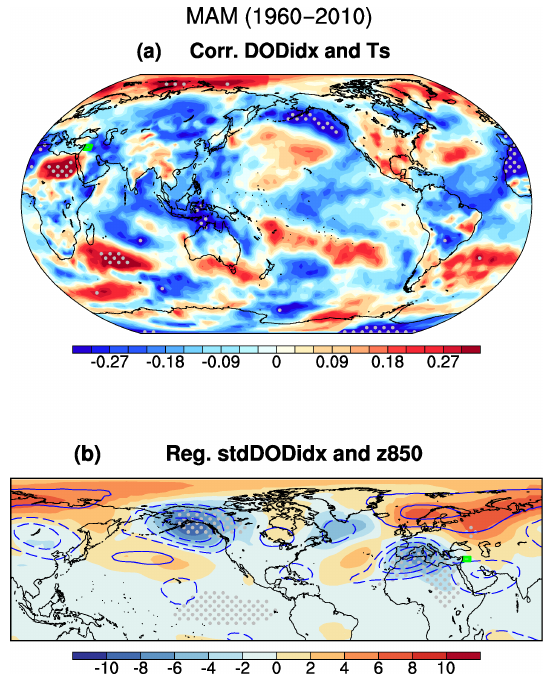
Figure 13. (a) Correlation between AM3 DOD index averaged over Syria (see Fig. 2) and surface temperature from 1960 to 2010 and (b) regression of 850hPa (shading) and 200hPa (contours; solid lines for positive values and dashed lines for negative values, from − 20 to 20gpm with intervals of 5gpm, zero line is not shown) geopotential height onto the standardized DOD index from 1960 to 2010. Shading areas significant at the 95% confidence level are